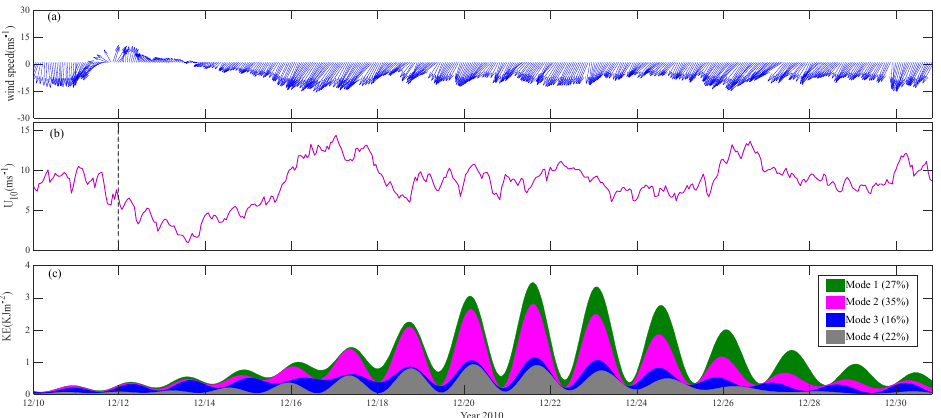
Figure 13. Time series of the wind ( a ), the wind speed amplitude ( b ), and the second strong NIKE ( c ) are marked by the black dashed rectangle in Figure 8. The values in the brackets indicate the percentage of the corresponding modal NIKE in the total NIKE (the combination of the four modes) during the corresponding observation period. The black dotted line denotes 0:00 on 12 December.